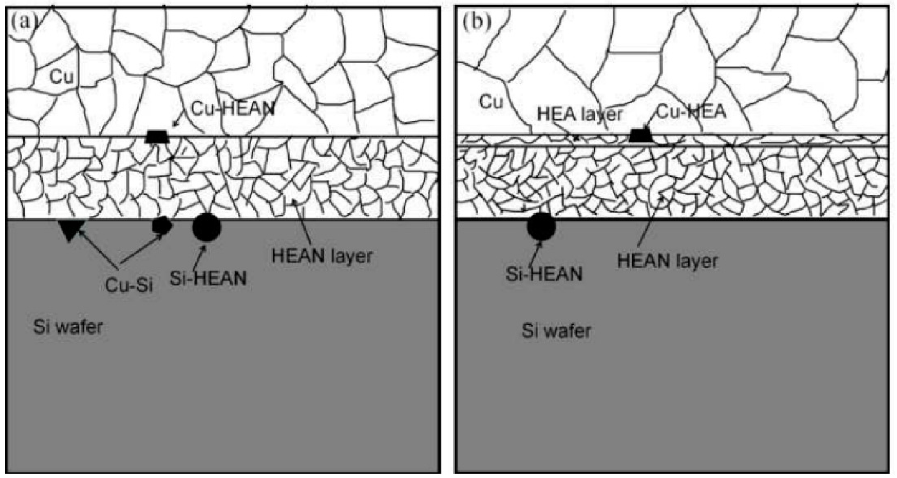
Figure 20. Specimen’s cross-sectional morphologies after static isothermal oxidation at 1100 °C (Specimen NN after ( a ) 50 h and ( b ) 100 h oxidation, Specimen NHN after ( c ) 50 h and ( d ) 100 h oxidation). Insets of EDS of precipitates in NN and NHN specimens after 100 h oxidation. Reprinted with permission from [160] Copyright 2021